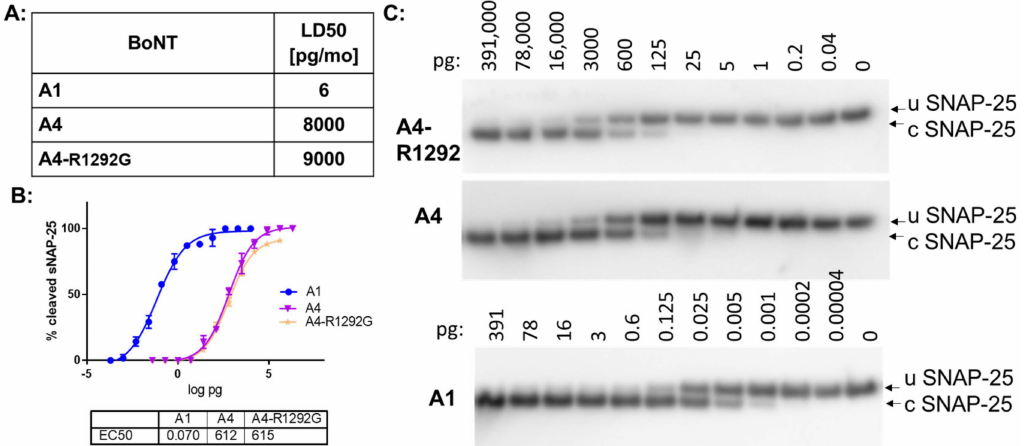
Figure 3. Mutational analysis of BoNT/A1 and BoNT/A4 protein receptor binding. ( A ) BoNT/A1, BoNT/A4, and BoNT/A4-R 1292 G variant were tested in the mouse bioassay. Four mice each were injected with an IP dose of the indicated BoNT/A and observed for 6 days, establishing a 50% potency, expressed as LD50 (pg/mouse). ( B ) Biologic activity of BoNT/A4-R 1292 G (A1-1M). Human iPSC derived motor neurons were exposed to the toxins for 48 h, and cell lysates analyzed for SNAP-25 cleavage by Western blot. The percent cleaved SNAP-25 was determined by densitometry, and average values and standard deviations were plotted in Prism6, n = 3. EC50 values were derived from a nonlinear four-parameter regression curve fit in Prism6. ( C ) Representative Western blots of the cell-based assay. U SNAP-25 (uncleaved SNAP-25), c SNAP-25 (cleaved SNAP-25). Table 2. Potency of BoNT mutants in mice and neuronal cell cultures. Mouse BoNT